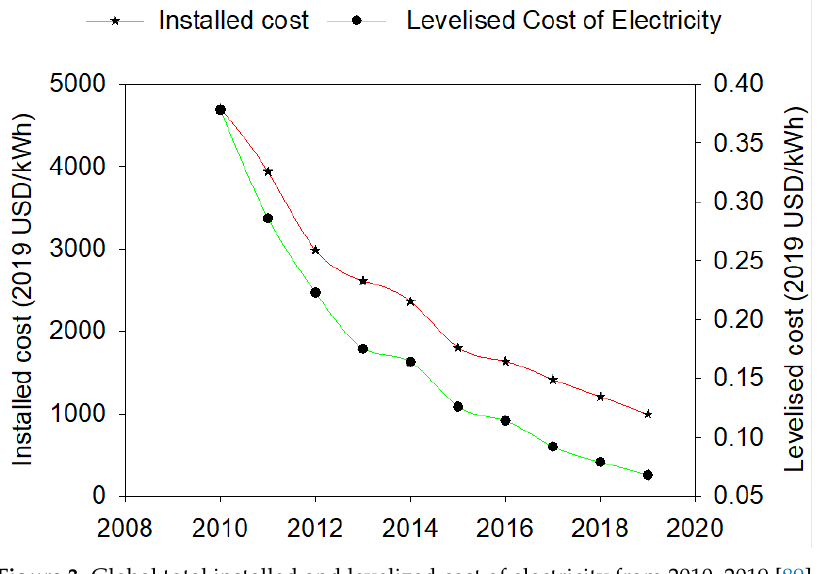
Figure 3. Global total installed and levelized cost of electricity from 2010–2019 [89].